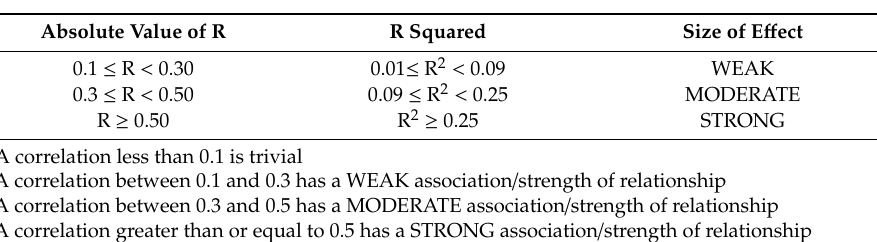
Table 1. Guidelines for classifying correlation coe ffi cients as developed by Cohen (1998).